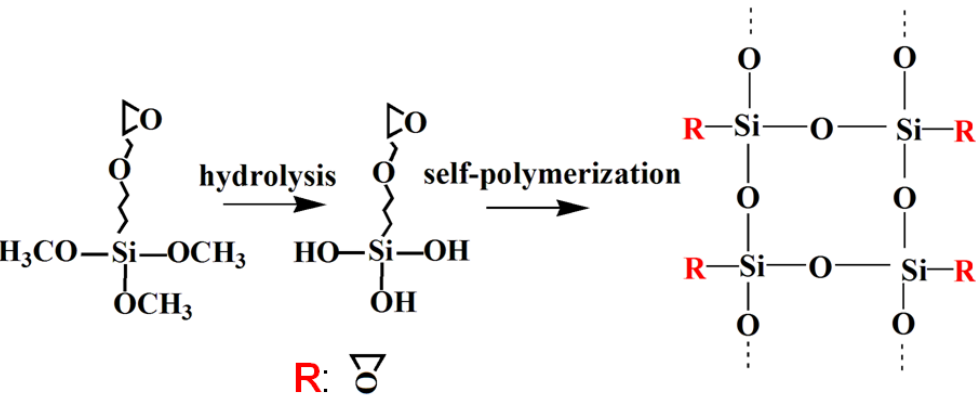
Figure 3. Structural schematic diagram of KH560 with self-polymerization. Table 2. The consumption of NaOH standard solution of blank and KH560-NCC.